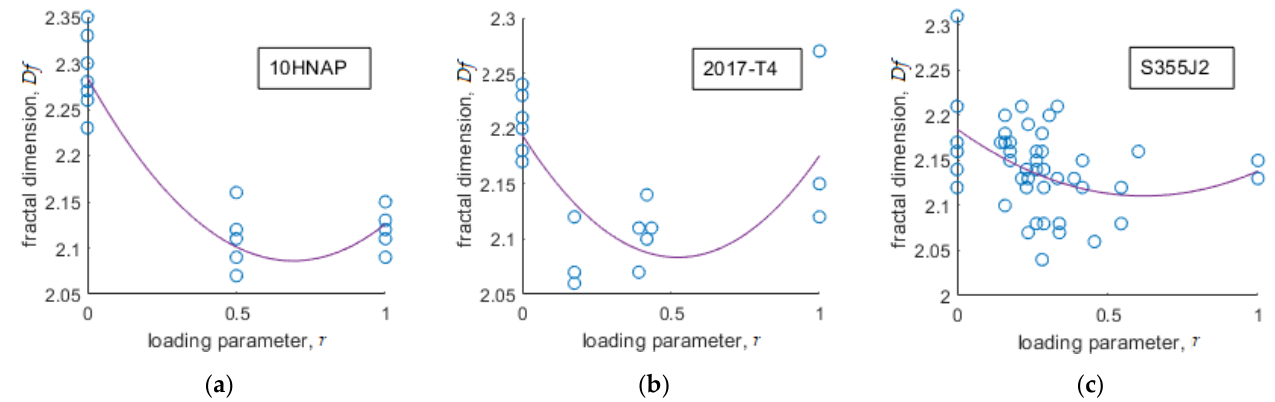
Figure 5. Fractal dimension Df evaluation at different applied loading stress ratios of the r parameter for the investigated materials: ( a ) 10HNAP steel, ( b ) 2017-T4 aluminium alloy, and ( c ) S355J2 steel.